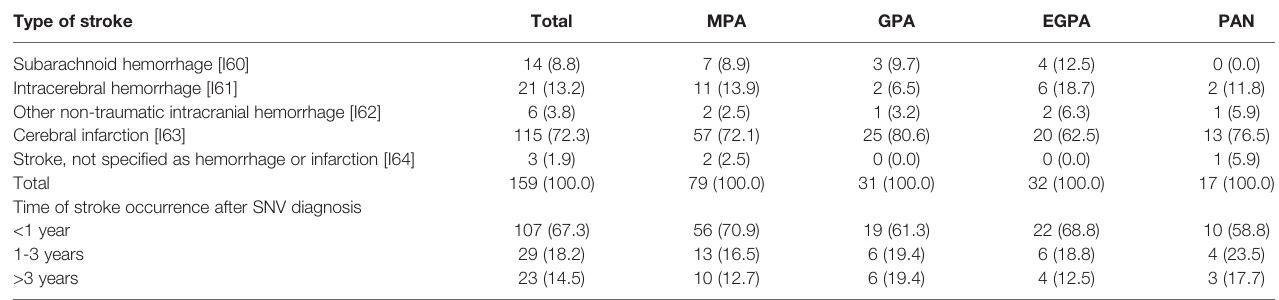
TABLE 2 | Type and incidence of stroke events after SNV diagnosis.